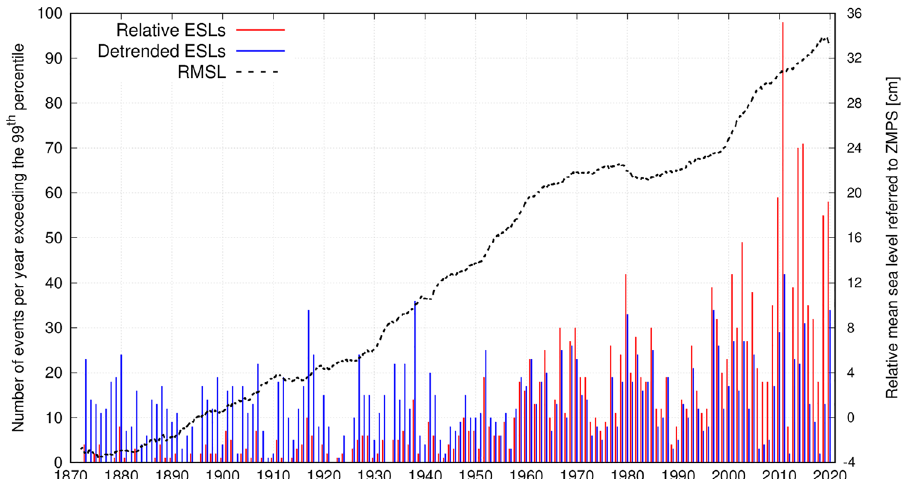
Figure 1. Number of events per year exceeding the 99th percentile threshold in the relative (red bars) and detrended (blue bars) sea-level datasets. The time evolution of the relative mean sea level (19-year running mean) is shown as a black dashed